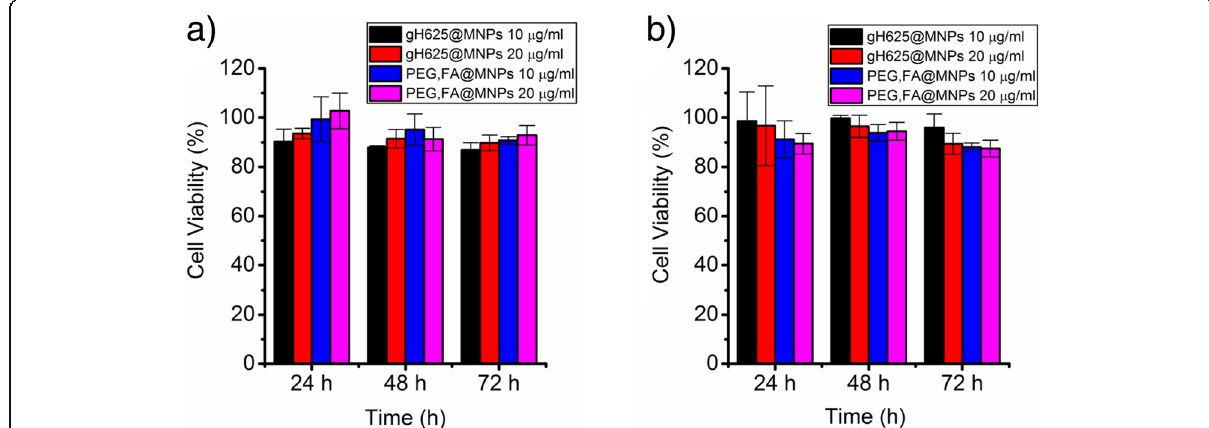
Fig. 6 Cell viability. Cell viability of a HBMEC and b A-172 cells incubated for 24, 48, and 72 h with gH625@MNPs 10 μ g/ml (black bar), gH625@MNPs